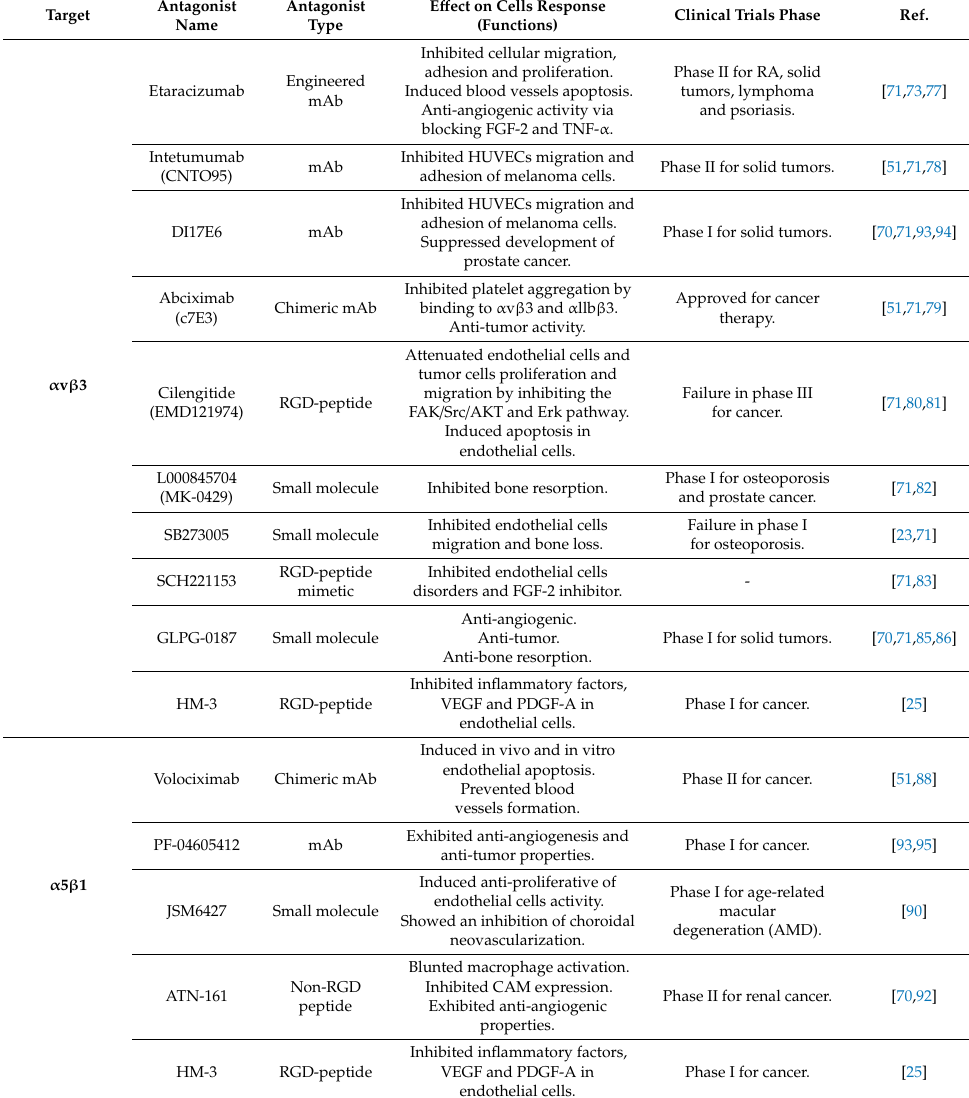
Table 1. Summary table of α v β 3 and α 5 β 1 integrin